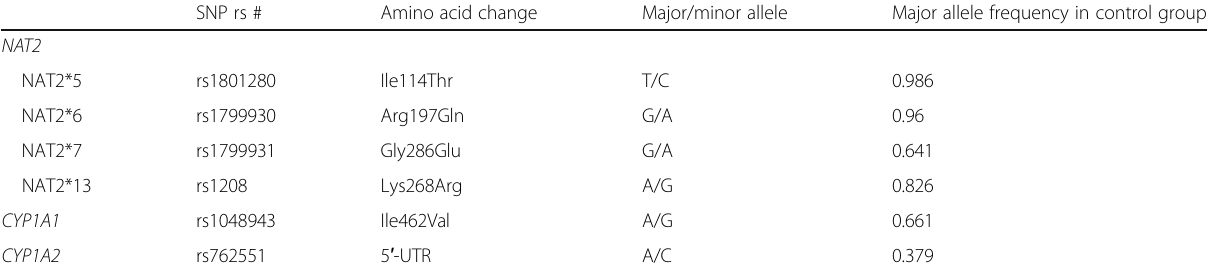
Table 2 SNPs and their allele frequencies in NAT2 , CYP1A1 , and